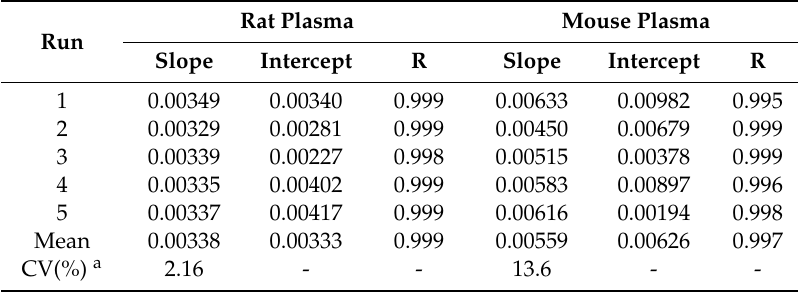
Table 2. Calibration curves for SH-1242 in rat and mouse plasma. Rat Plasma Mouse Plasma Run Slope